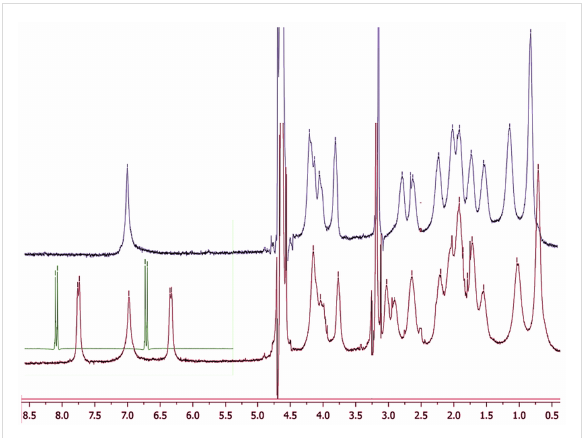
Figure 6: 1 H NMR spectra (D 2 O) spectra of CAP − 1 (blue), 8 (green, aromatic region only) and their 1:1 complex